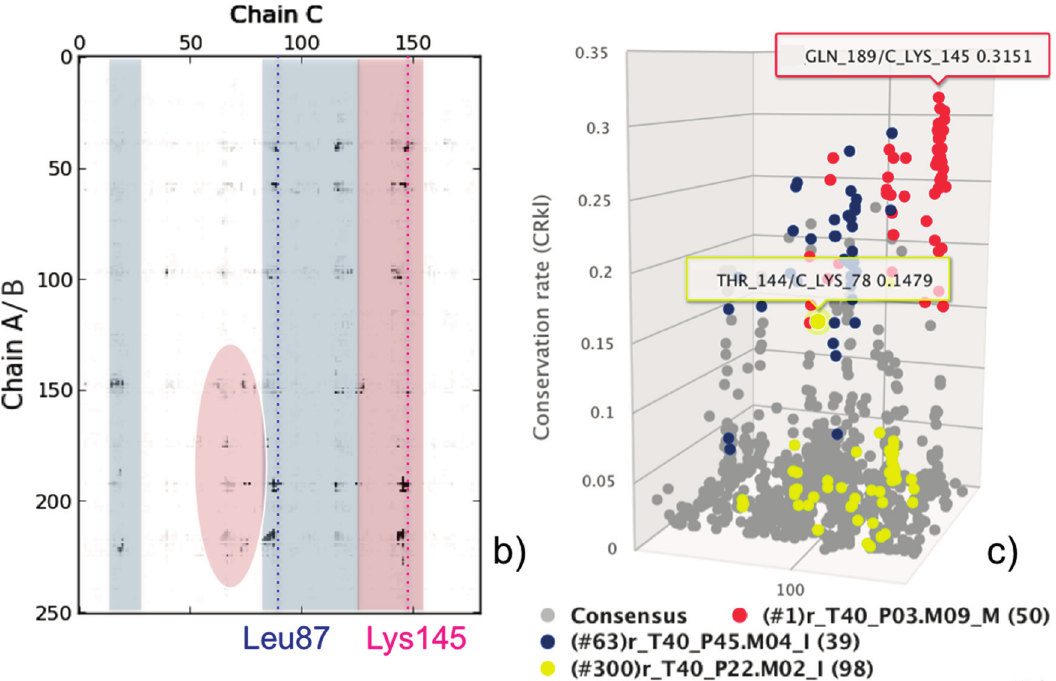
Figure 2. CAPRI target T40. ( a ) Cartoon representation of the trimeric API-A-trypsin complex with the two alternative API-A position P1 residues, Lys145 (interface AC) and Leu87 (interface BC) labelled; ( b ) Consensus map for the ensemble of 368 models submitted for T40 by predictors in CAPRI. Residues corresponding to the two interfaces are highlighted in red and blue, respectively; ( c ) 3D consensus map for the same ensemble of 368 T40 models. The model ranked first (red) corresponds to a correct solution according to the AC interface; the model ranked 63rd (blue) corresponds to a correct solution according to the BC interface; the model ranked 300th (yellow) corresponds to an incorrect solution according to either interface. The contacts consensus is shown in gray. The most frequent contact, between trypsin Lys145 and API-A Gln189, and the native-like contact between trypsin Lys78 and API-A Thr144, also present in the shown incorrect model (yellow), are labelled, and their conservation rate is shown as in the server interactive